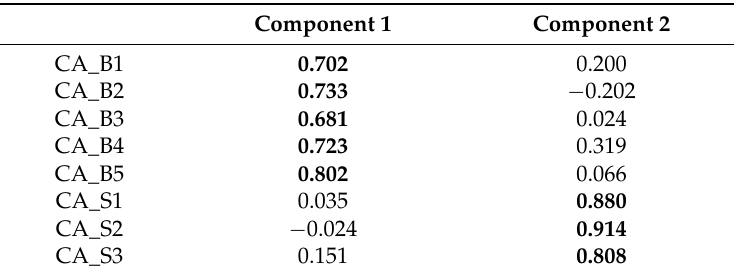
Table 5. Rotated component matrix of cognitive affective